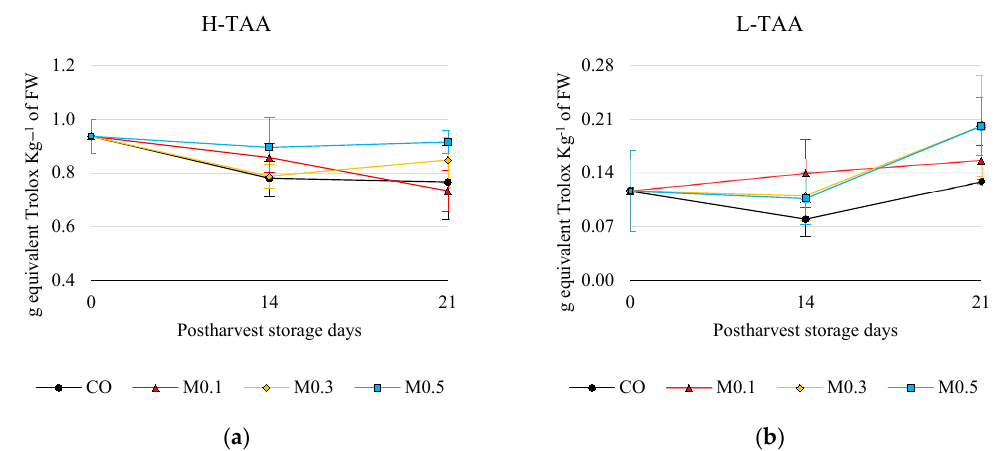
Figure 4. Antioxidant activity of ‘Samba’ cherries in relation to treatments and storage time. ( a ) Hydrophilic total antioxidant activity (H-TAA). ( b ) Lipophilic total antioxidant activity (L-TAA). Mean values ± SE ( n = 3).